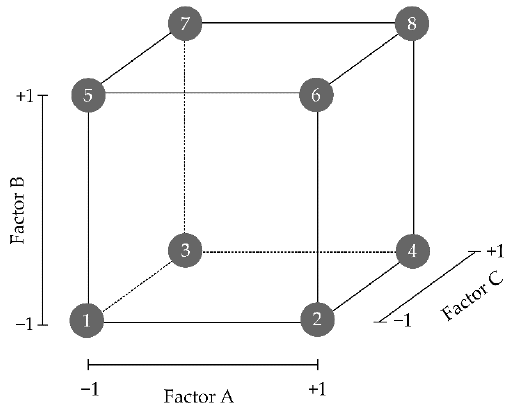
Figure 4. A geometric representation of the eight runs (dark spheres at vertices 1 to 8) of a three-factor, two-level (2 3 ) full factorial design. Each factor (A, B and C) is established at two levels, coded as − 1 (low level) and +1 (high level). Note that each experimental run (vertices of the cube, numbered 1 to 8) is a unique combination of the different levels for the factors. Full factorial experimental designs are a very cost-effective solution when a low num- ber of factors is considered. All possible combinations between the considered factors and levels are studied, maximising the amount of information that can be obtained from an experimental effort. Augmenting the number of factors under study will lead to an expo- nential increase in the required experimental runs. In several cases, due to time or eco- nomic limitations, performing all the experimental runs can become impractical [108]. In this case, a fractional factorial design can be postulated, where only a subset of the exper- imental runs is executed, while maintaining good predictability. Since only a subgroup of the runs is executed, only a subset of the equation terms can be properly estimated. The remaining unstudied terms are said to be aliased or confounded amongst themselves. The simplified regression model is still acceptable, considering several statistical principles.